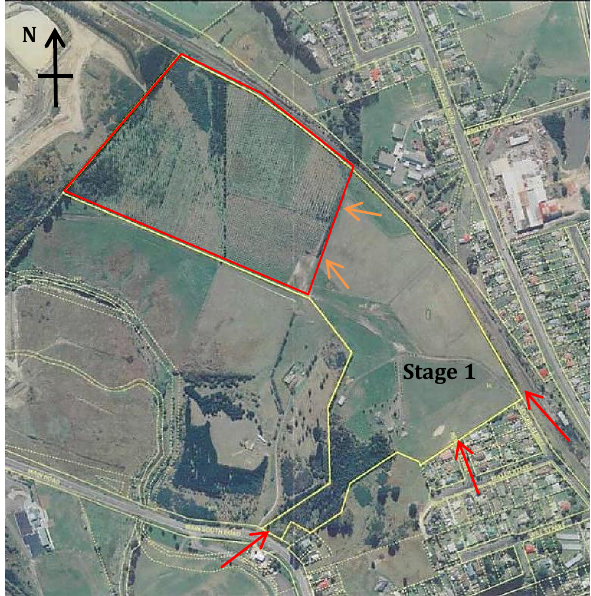
Figure 1. The study site, Grand Vista. The yellow boundary highlights the whole re-designated zone. The red line indicates the target area for the 3D design environments. Figure 2a details the development and assessment process, covered in the next three